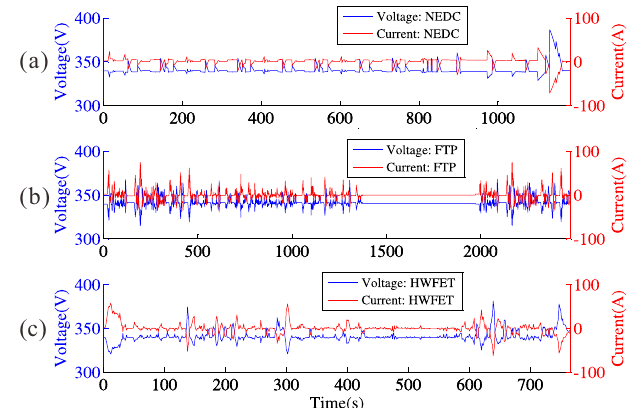
Figure 13. Battery voltage and current under ( a ) NEDC, ( b ) FTP and ( c ) HWFET driving cycles.